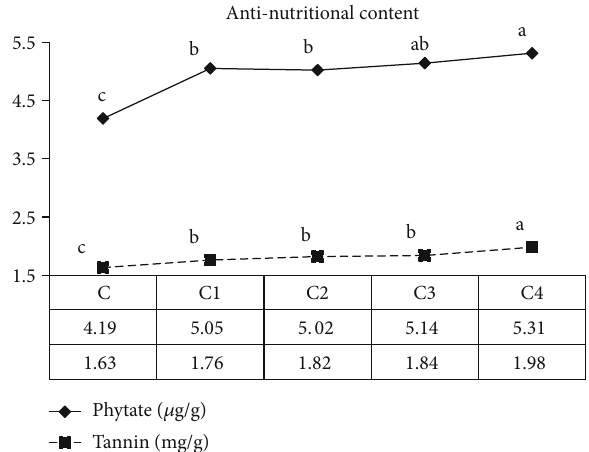
Figure 1: E ff ect of blending ratio on antinutritional content of wheat-amaranth-based bread.